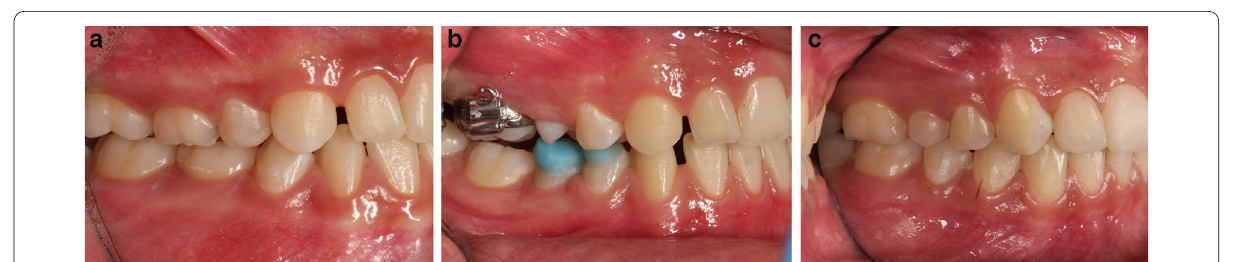
Fig. 4 a – c Lateral occlusal photographs of one patient of the study group at T0, T1, and